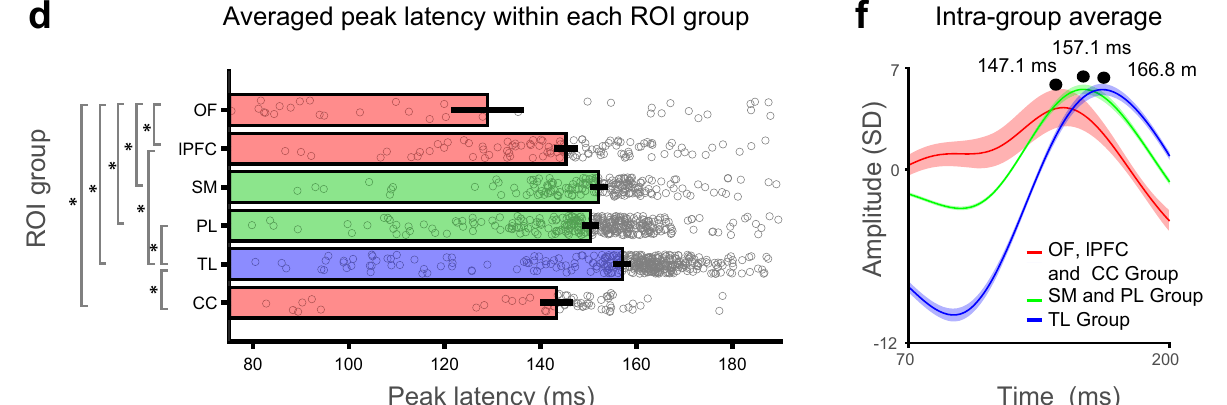
and CC group, respectively. Abbreviation is the same as in Fig. 4. See Supplemen- tary Fig. 3b for lateral amygdala stimulation. Color of bars indicates ROI